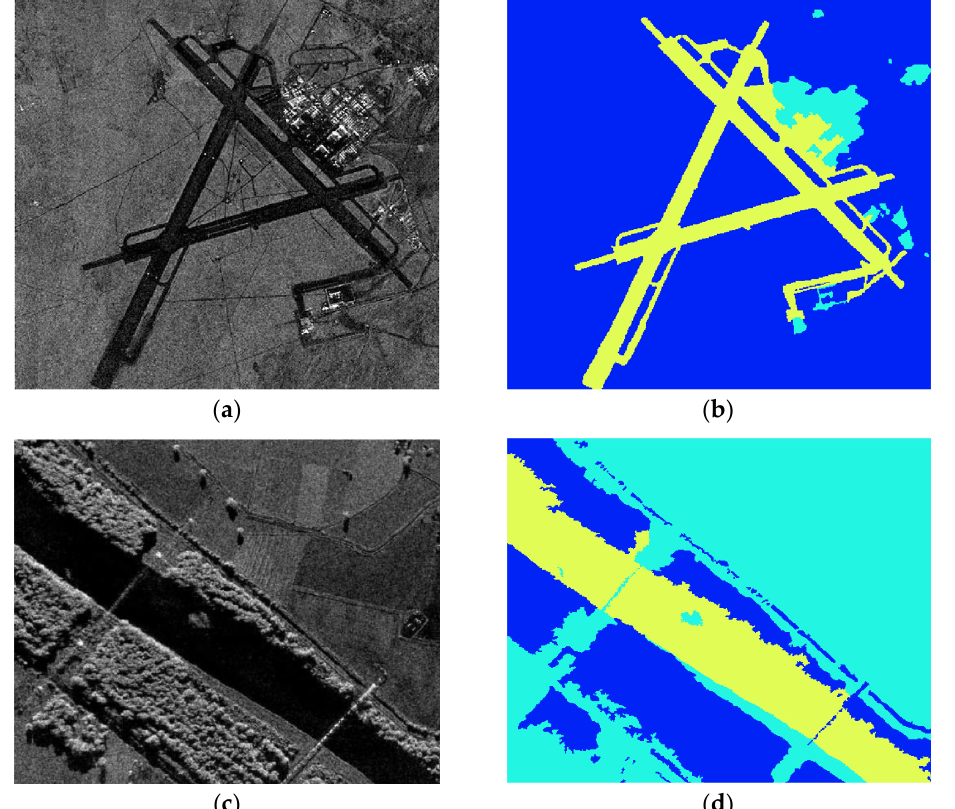
Figure 9. ( a ) Real SAR image SI 4 ; ( b ) the ground truth of SI 4 ; ( c ) real SAR image SI 5 ; ( d ) the ground truth of SI 5